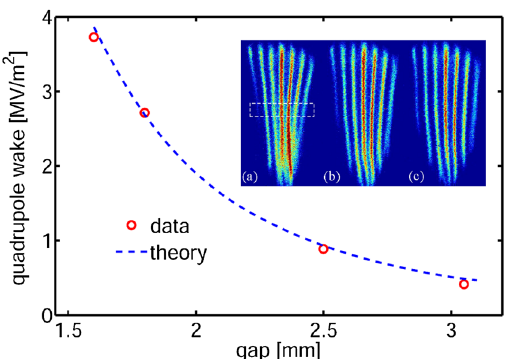
FIG. 9. Measured (red circles) and simulated (blue dashed line) quadrupole wakefields of the central slice at various gaps. The streaked beamlets at various CS gaps are shown in the insets [(a) for g ¼ 3 . 6 mm, (b) for g ¼ 5 . 0 mm and (c) for g ¼ 6 . 1 mm].The dashed square indicates the region of the central slice used for